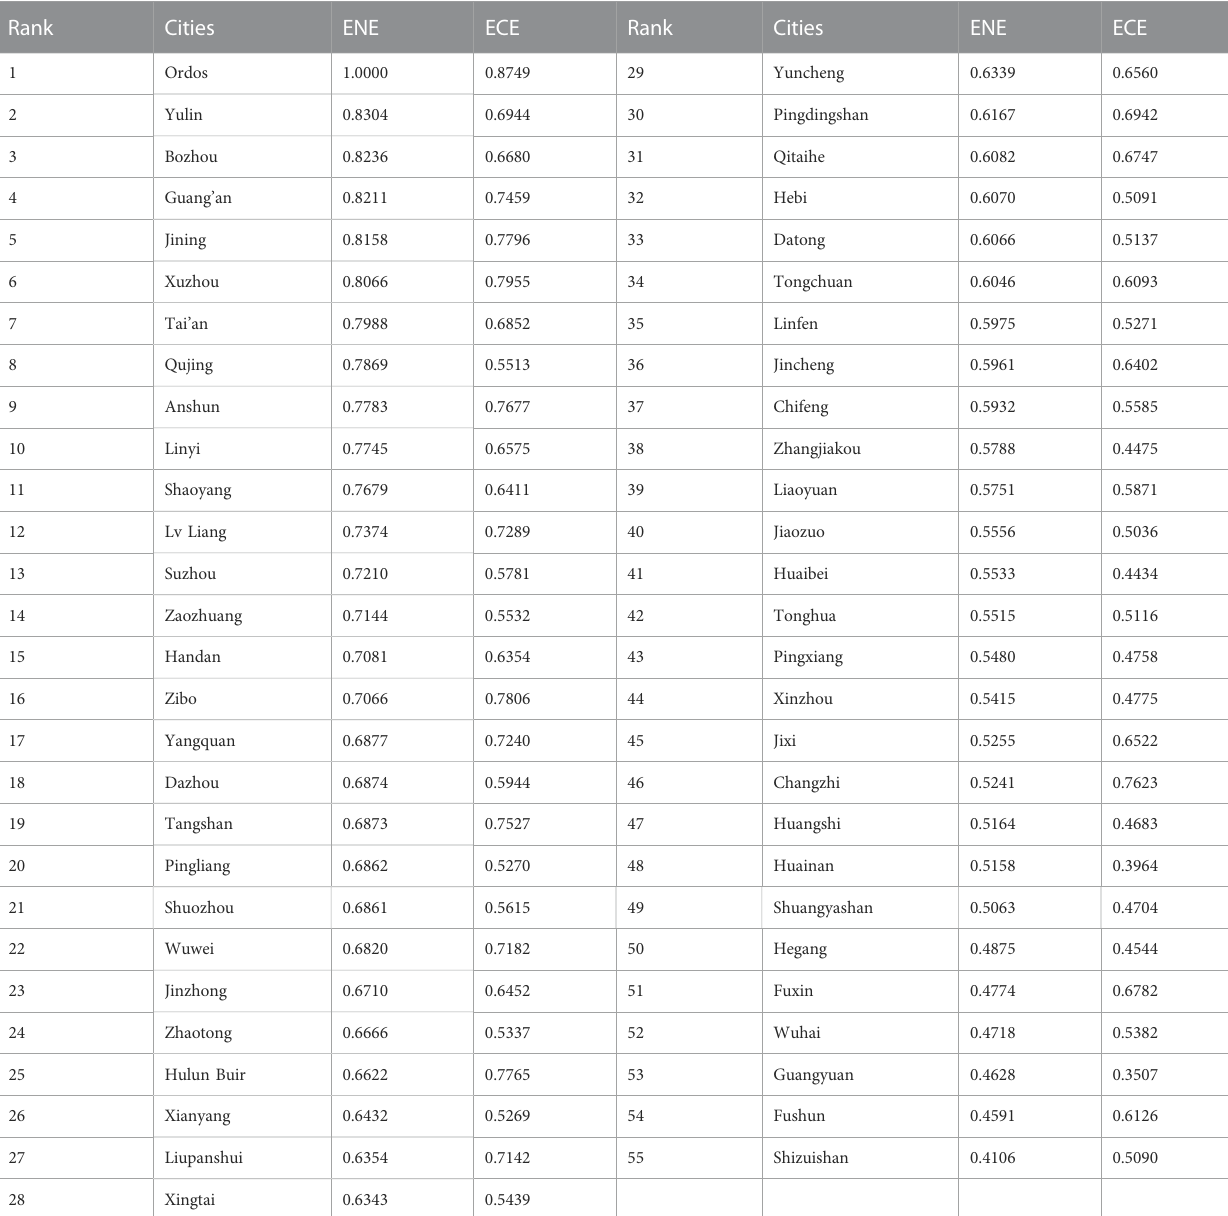
TABLE 2 Economic and environmental ef fi ciencies ranking of coal cities. Rank Cities ENE